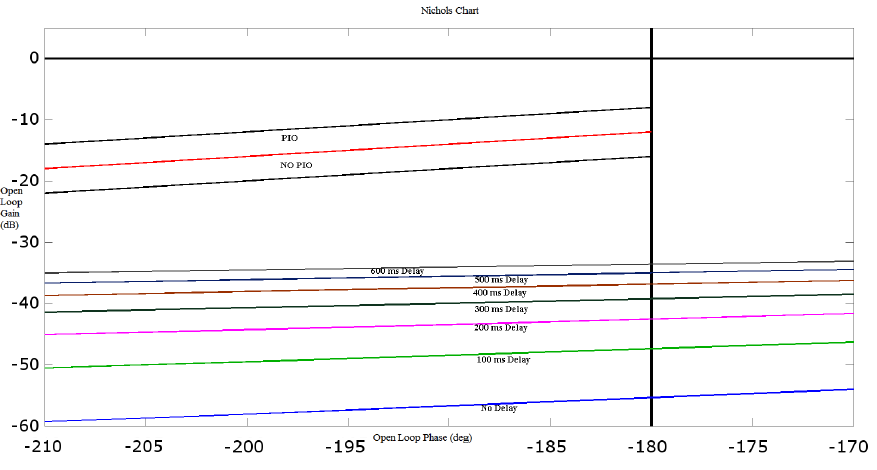
Figure 7. Gain phase template for “Phastball”